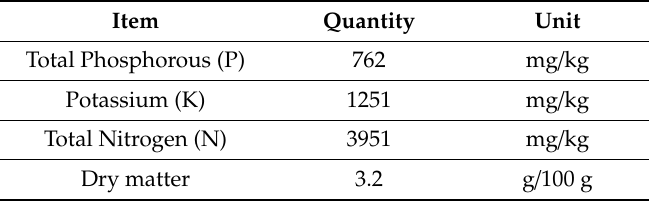
Table 11. The quantity of the three basic nutrients of fertiliser and dry matter weight in the